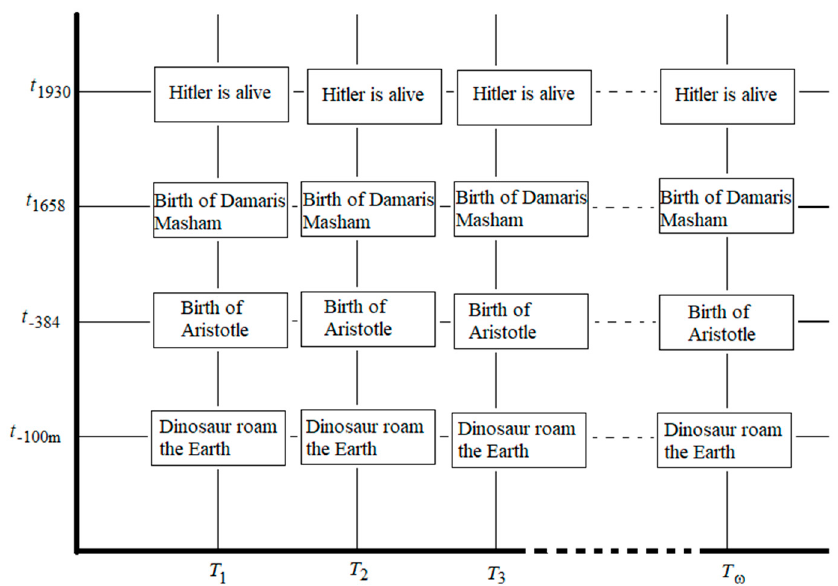
Figure 2. An exterminous hypertemporal world with no time travel.